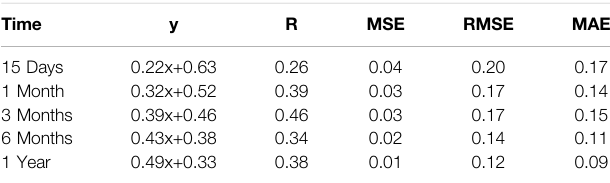
TABLE 5 | CO 2020 model performance statistics with different time period in Jiangsu Province. Time